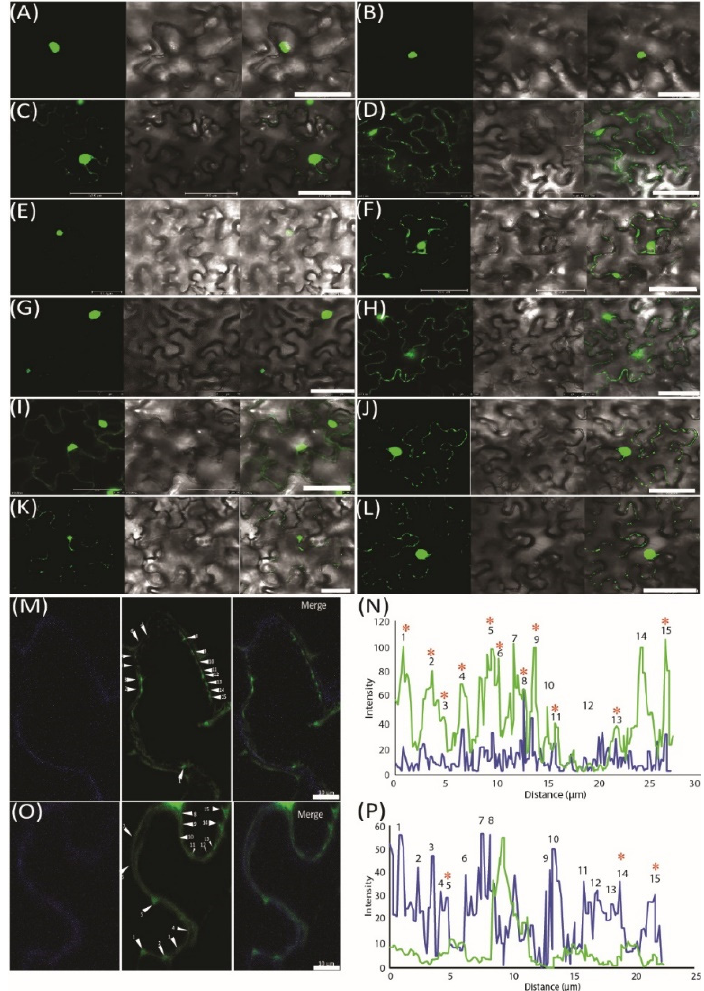
Figure 3. Pre form (rather than pri form) of root-to-shoot mobile miRNAs that were targeted toward plasmodesmata (PD). ( A ) MS2 FD -GFP localization in the nucleus of Nb epidermal cells 2 days after Agrobacterium infiltration. ( B ) Co-infiltration of MS2 FD -GFP and an SL 24 empty vector. ( C ) Co-infiltration of MS2 FD -GFP and an Actin2-SL 24 negative control. (D ) Co-infiltration of MS2 FD -GFP and SL 24 -FT ( FLOWERING LOCUS T ) used as a positive control. ( E ) Pri-Nb-miR395-1 co-expressed with MS2 FD -GFP. ( F ) Pre-Nb-miR395-1 co-expressed with MS2 FD -GFP. ( G ) Pri-Nb- miR397v co-expressed with MS2 FD -GFP. ( H ) Pre-Nb-miR397v co-expressed with MS2 FD -GFP. ( I ) Pri- Nb-miR164v co-expressed with MS2 FD -GFP. ( J ) Pre- Nb-miR164v co-expressed with MS2 FD -GFP. ( K ) Mature Nb-miR164v fused with SL 24 and its co-expression with MS2 FD -GFP. ( L ) Three tandem repeats of Nb-miR164v (3x Nb-miR164v -SL 24 ) fused with SL 24 and its co-expression with MS2 FD -GFP. ( M ) Co-expression of 3xNb-miR164v-SL 24 and MS2 FD -GFP in aniline blue-stained N. benthamiana leaves. Left: image taken in the aniline blue channel. Middle: image taken in the GFP channel. Right: merged image from left and middle image. ( N ) Co-localization analysis of the GFP foci in 3xNb-miR164v-SL 24 transiently expressing leaves. ( O ) Co-expression of non-mobile Actin2-SL 24 RNA and MS2 FD -GFP in aniline blue-stained N. benthamiana leaves. Left: image taken in the aniline blue channel. Middle: image taken in the GFP channel. Right: merged image from left and middle image. ( P ) Co-localization analysis of the GFP foci in Actin2-SL 24 transiently expressing leaves. The numbers in ( M – P ) represent individual GFP spots. Co-localization of the GFP signal with aniline blue is indicated by a star sign. Scale bar in ( A – L ) represents 50 µ m and scale bar in ( M , O ) represents 10 µ